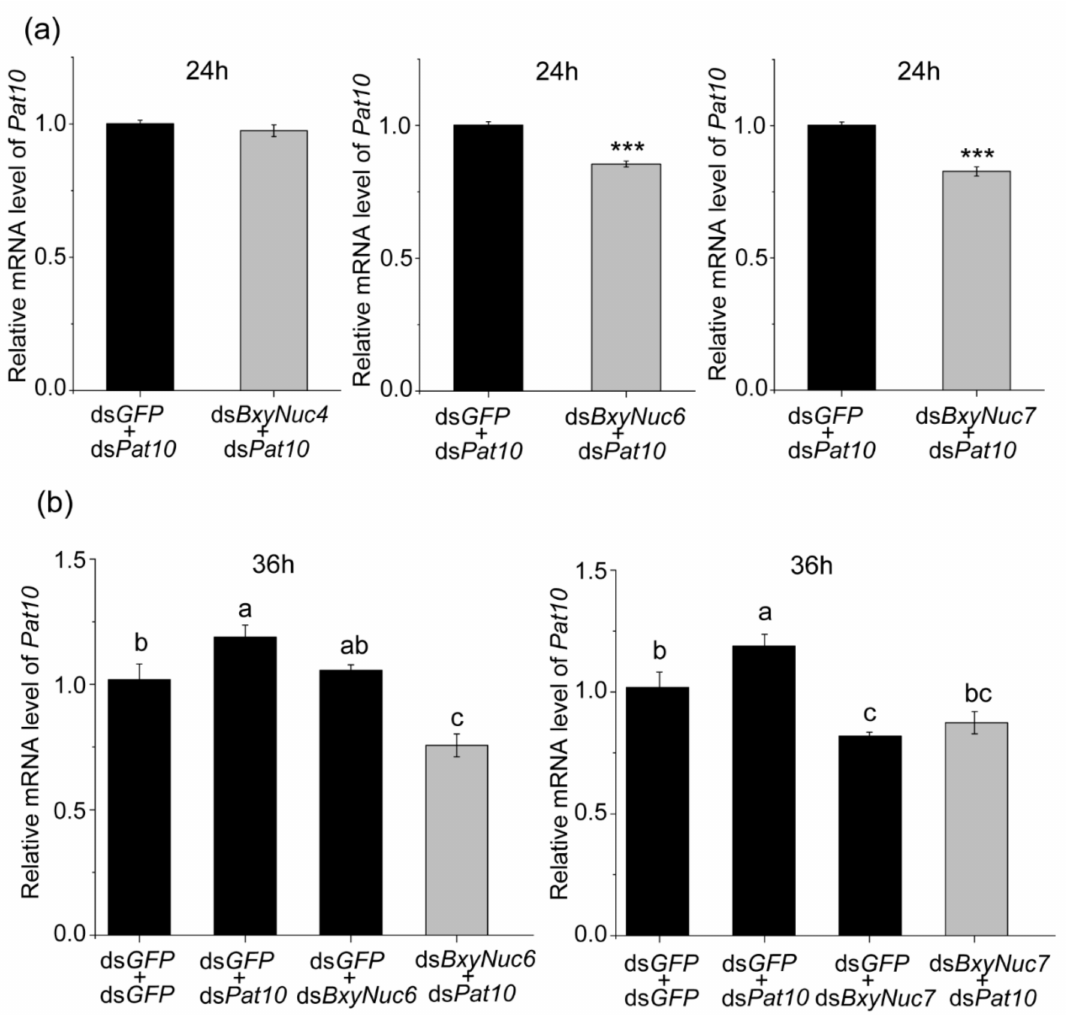
Figure 7. The relative expression level of Pat10. ( a ) The relative mRNA level of Pat10 after interfering with Pat10 gene and nucleases BxyNuc4 / BxyNuc6 / BxyNuc8 genes simultaneously for 24 h. ( b ) The relative mRNA level of Pat10 after interfering with Pat10 gene and nucleases BxyNuc6 / BxyNuc7 genes simultaneously for 36 h. Gene expression differences between two groups were calculated using the independent samples t test. Data are presented as mean ± SE, *** p < 0.001; different letters indicate significant difference ( p <